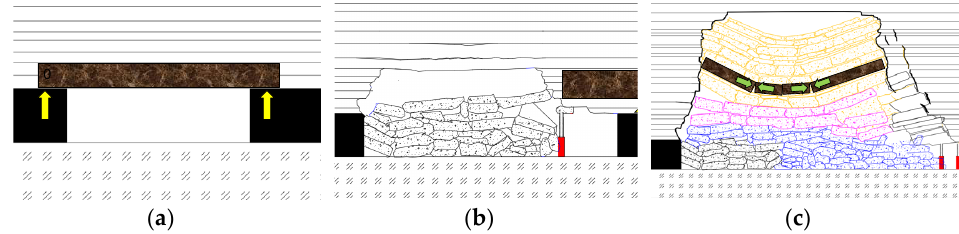
Figure 1. Structure evolution process of mining overburden. ( a ) Fixed beam structure; ( b ) cantilever beam structure; ( c ) masonry beam structure.